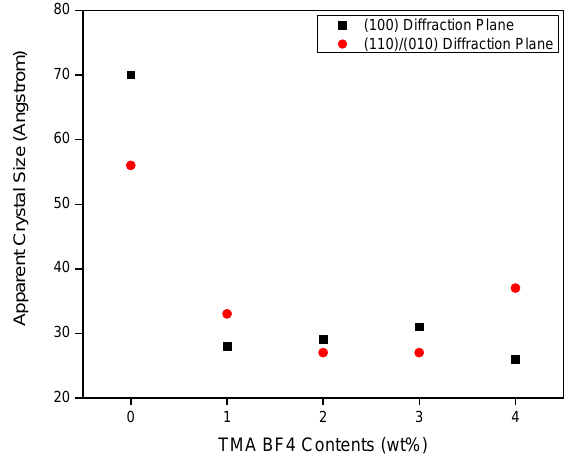
Figure 9. Apparent crystal size of the as-spun salt-confined nylon 6,6 fibres.